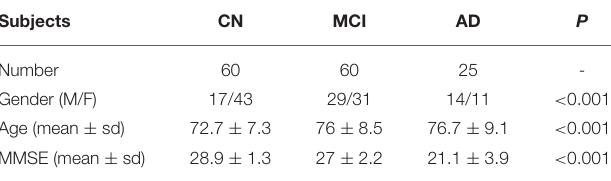
TABLE 1 | The clinical characteristics of subjects.